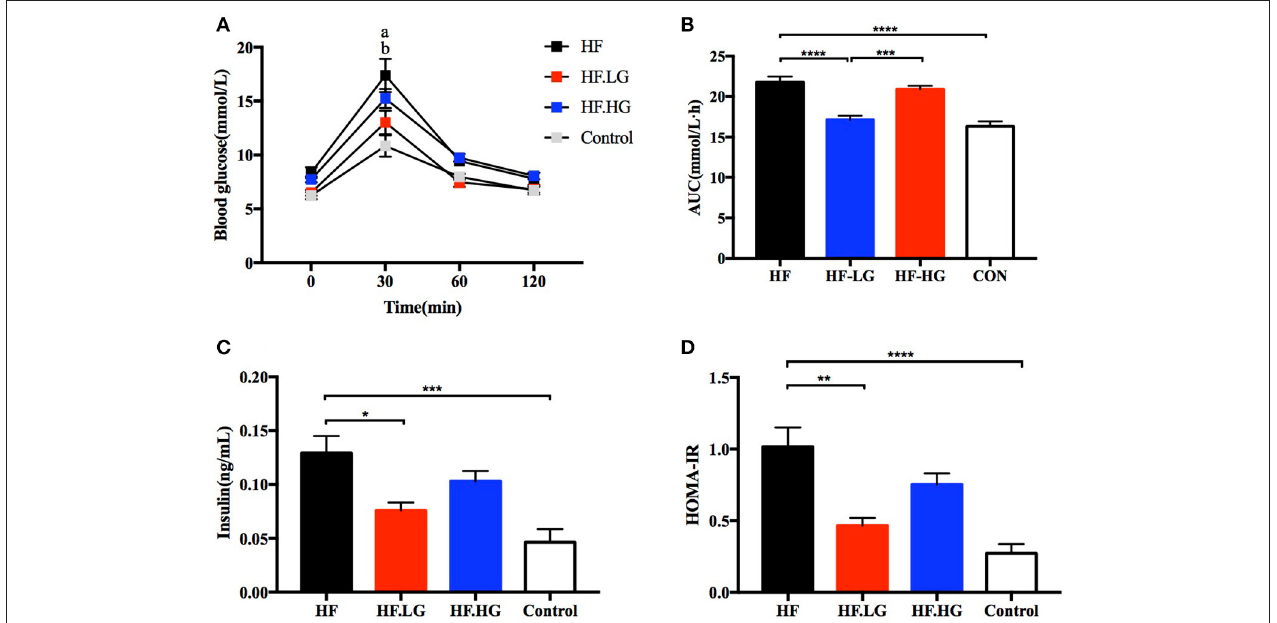
FIGURE 2 | Glucose metabolism of the female offspring at weaning. (A) OGTT; (B) AUC; (C) Serum insulin levels; (D) HOMA-IR. HF, high-fat diet without genistein; HF. LG, high-fat diet with low-dose genistein; HF. HG, high-fat diet with high-dose genistein; Control, normal control diet; OGTT, oral glucose tolerance test; AUC, area under the curve; HOMA-IR, the homeostasis model assessment of insulin resistance. Data are expressed as means ± S.E.M. ( n = 6-8/group). Mean values were significantly different between other group and the HF group: * p < 0.05, ** p < 0.01, *** p < 0.001, **** p < 0.0001; Mean values were significantly different between Control group and the HF group: ‘a’ p < 0.0001; Mean values were significantly different between HF.LG group and the HF group: ‘b’ p < 0.001.